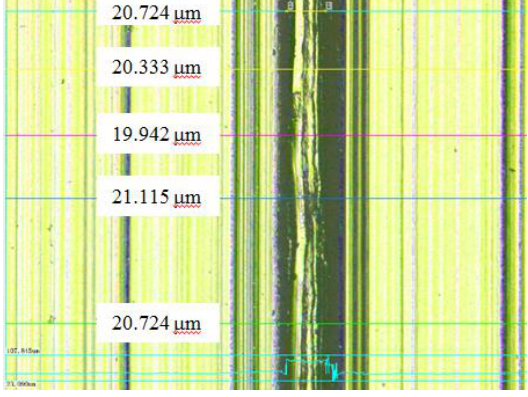
Figure 11. The rib width at the rotation speed of 2000 r/min.